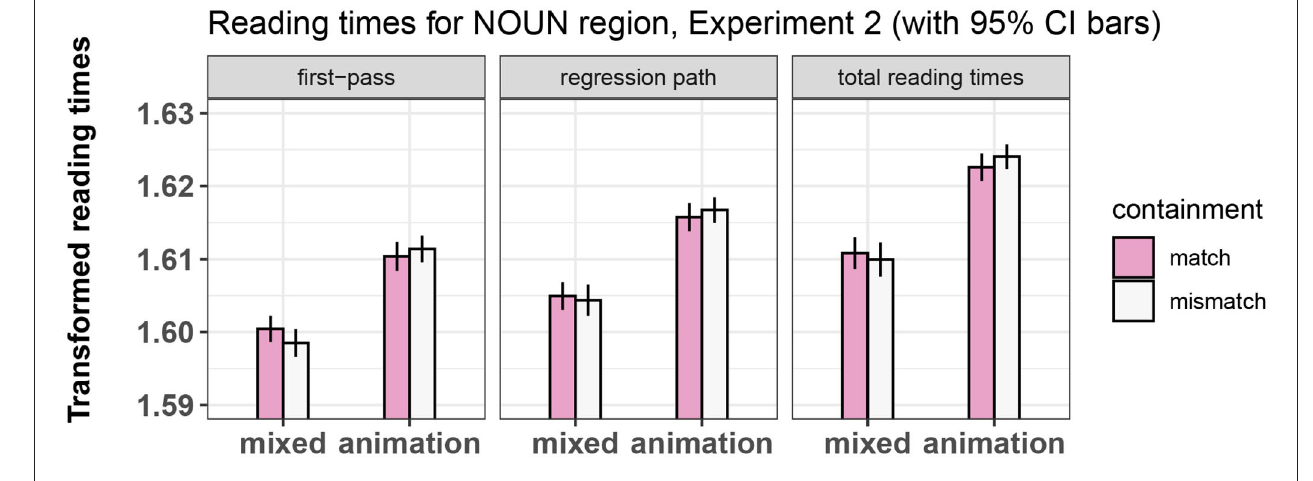
FIGURE 8 | Summary of results for the NOUN region, Experiment 2.